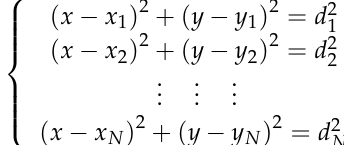
Figure 10. Relationship between σ 2 e and M for d k = 2